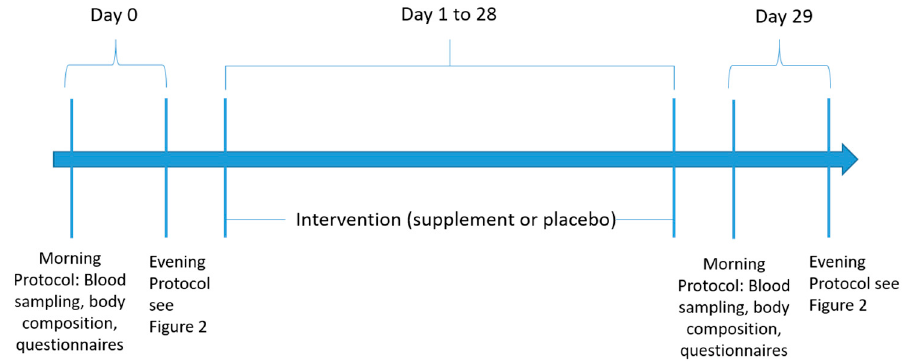
Figure 1. Schematic view of the study.